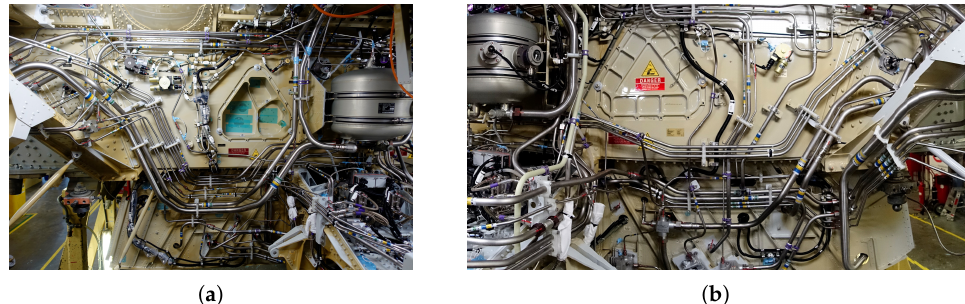
Figure 20. Piping series solution in an Airbus A320 main landing gear bay (©2022 Airbus). ( a ) left side main landing gear bay, ( b ) right side main landing gear bay.